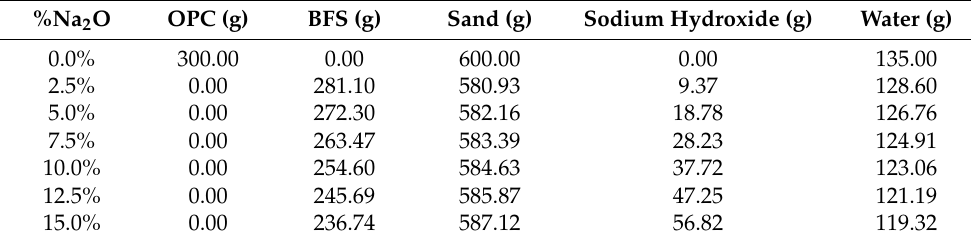
Table 2. Compositions of